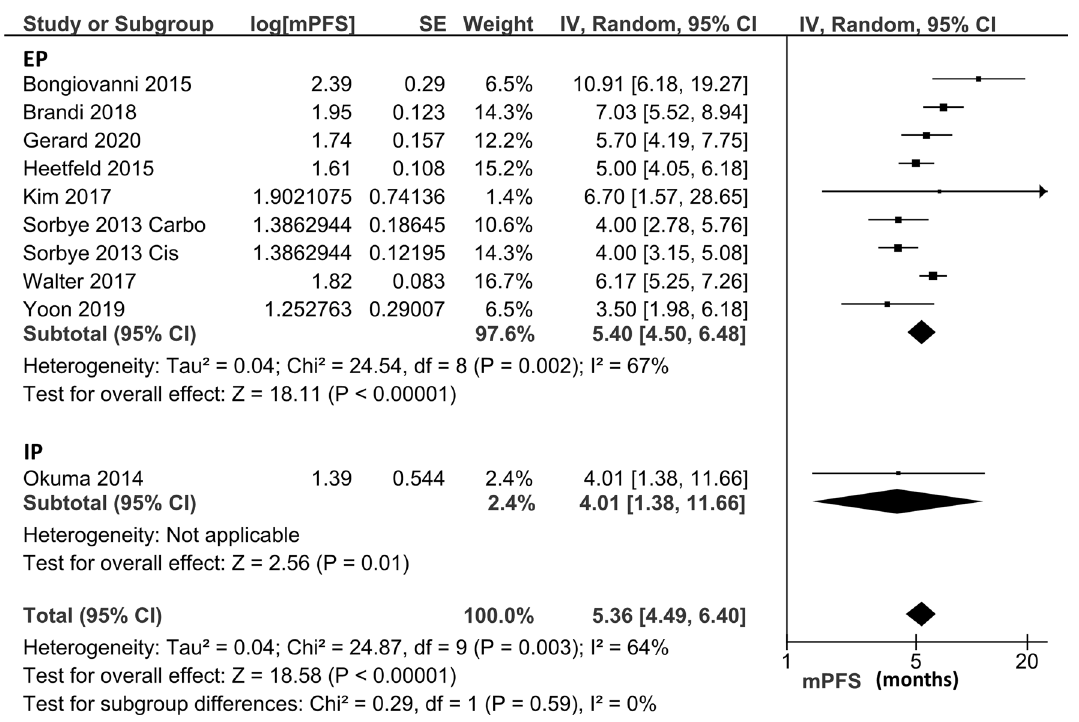
Fig. 6 Pooled median PFS in patients treated with platinum-doublet chemotherapy. Eight studies that evaluated patients treated with EP and one study that evaluated patients with IP were included in this analysis. EP platinum plus etoposide, IP platinum plus irinotecan, PFS progression-free